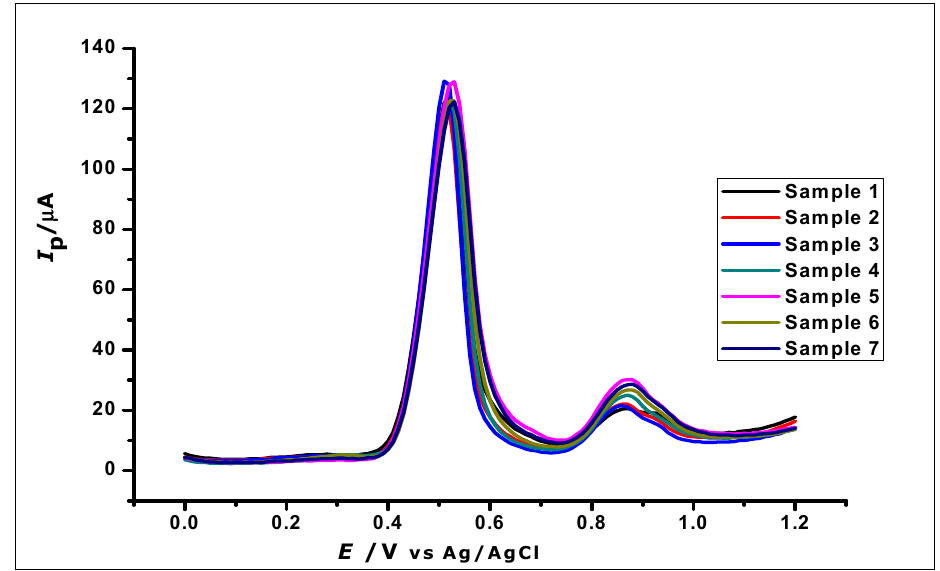
Figure 14. DPV Voltammogram of 1 × 10 − 3 mol L − 1 gallic acid using ZrO 2 nanoparticles modified-CPE to demonstrate